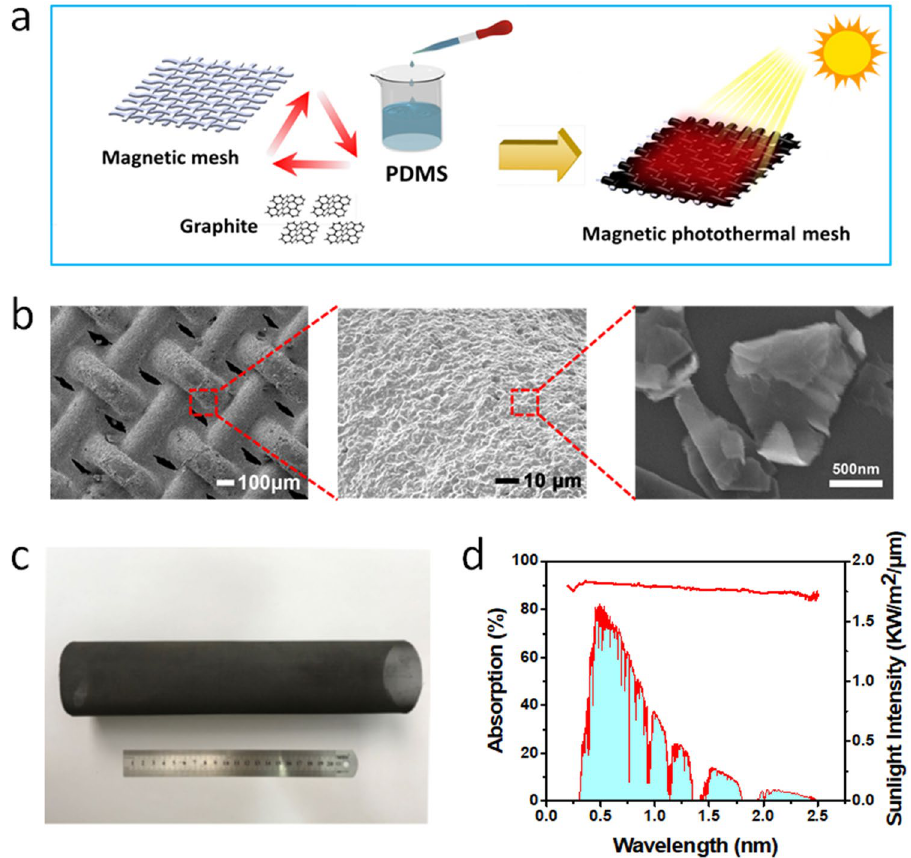
Figure 2. Preparation and characterization of MSCM. ( a ) Schematic for preparation of magnetically-response solar–thermal conversion mesh (MSCM) through a dip-coating method. ( b ) SEM images of MSCM under different magnifications showing its porous structure and enhanced surface roughness with graphite-PDMS coating. ( c ) An optical photograph of MSCM with a large size. ( d ) A UV–Vis–NIR absorption spectrum of MSCM and its comparison to solar